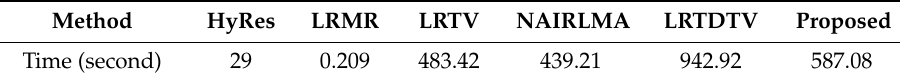
Table 3. Comparison of the running